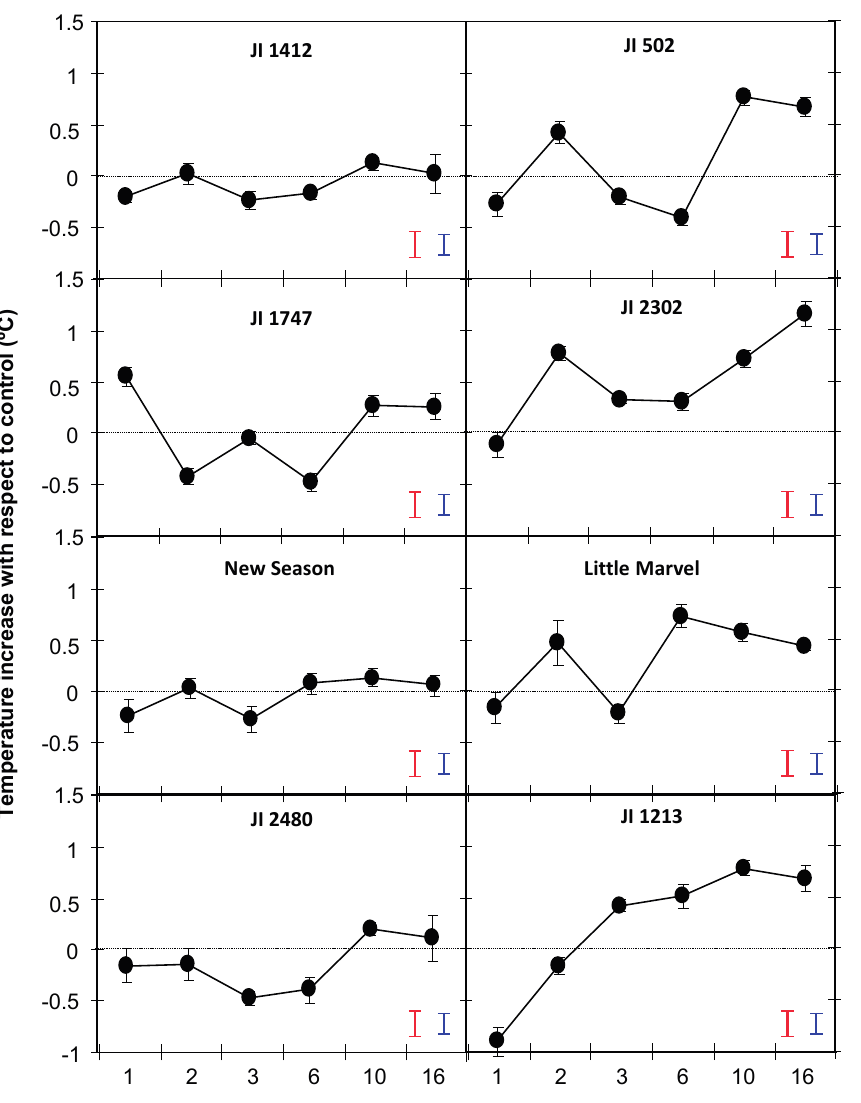
Figure 2. Evolution of the surface leaf temperature of P. sativum plants following inoculation with F. oxysporum f. sp. pisi ( Fop ). The graphs represent the evolution of the differences in surface temperature between Fop -inoculated and control plants for the resistant accessions JI 1412, JI 1747, JI 2480 and New Season, the partially resistant, JI 502, JI 2306 and Little Marvel, and the susceptible accession JI 1213 according to the time post-inoculation. Surface leaf temperatures were measured by infra-red imaging system. Vertical bars on each data point are standard errors for n = 10. Red and blue vertical bars represent the LSD values at α = 0.05 between genotypes (LSD = 0.26) and time points (LSD = 0.21), respectively. Thus by 10 dpi the temperature of JI 1412, JI 1747, JI 2480 and New Season was not different